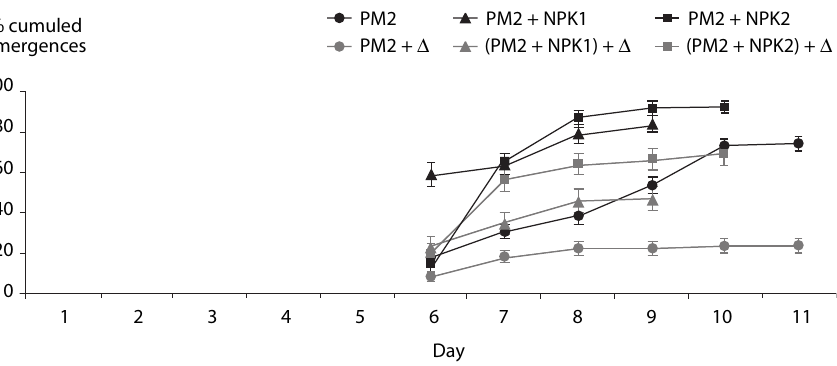
).Fig. 2. – Cumulated percen- tages of male and female adults of Anopheles gambiae VKPR strain whose larvae lived in environments composed of plant matter (PM1) alone or in combination with a NPK fertilizer, treated or untreated with deltamethrin ( Δ